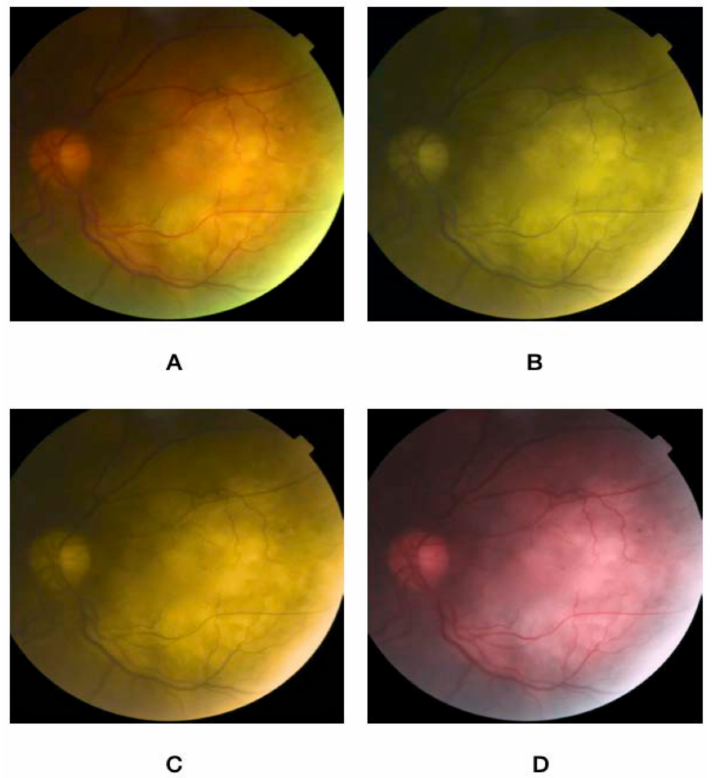
Figure 3. Fundus images for choroidal metastasis ( A ), under simulated protanopia ( B ), deuteranopia ( C ), and tritanopia ( D ).